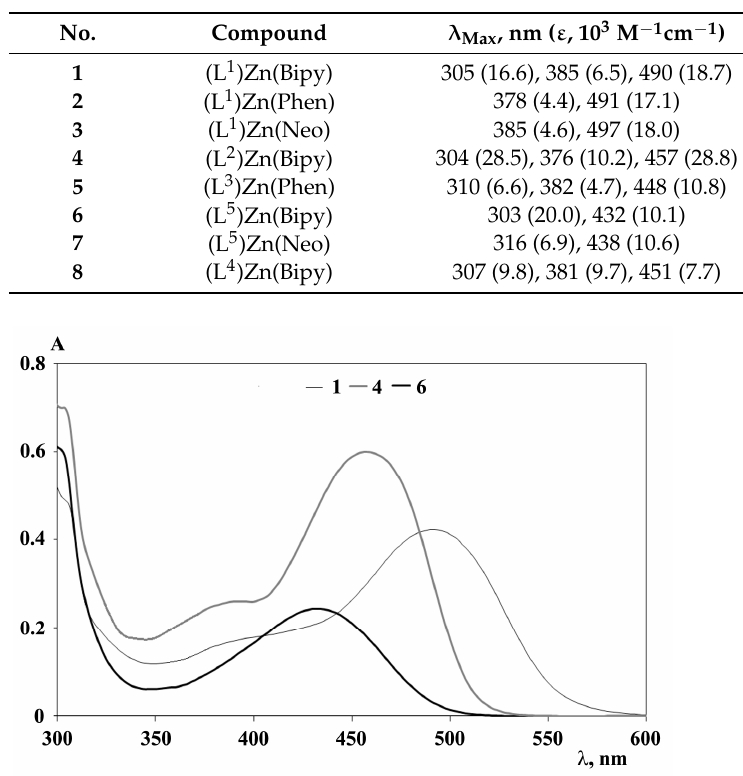
Figure 10. The UV-vis spectra of complexes 1 , 4 , 6 in CHCl 3 at 293 К ( С = 2.5 × 10 − 5 mol/L).